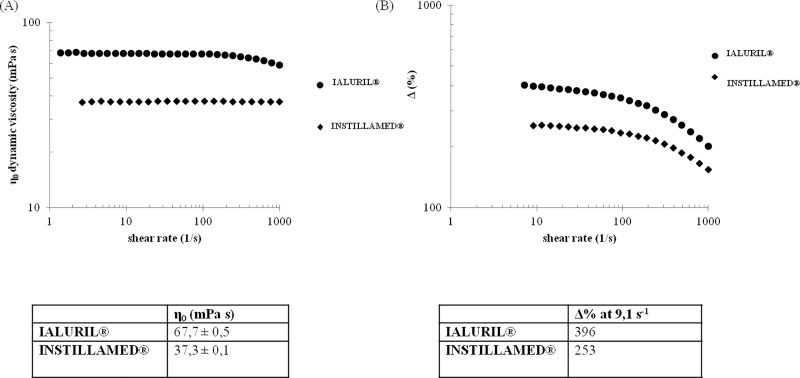
Comparison of two commercial medical devices for HA/CSb instillation.(A) Flow curves in the range of 1–1000 s-1 were performed at 37°C; η0 values are shown for IALURIL and INSTILLAMED. (B) The mucoadhesion indexes (Δ%) of IALURIL and INSTILLAMED is plotted as a function of the shear rate (a) and Δ% measured at a shear rate of 9.1 s-1 according to previously reported method [10].